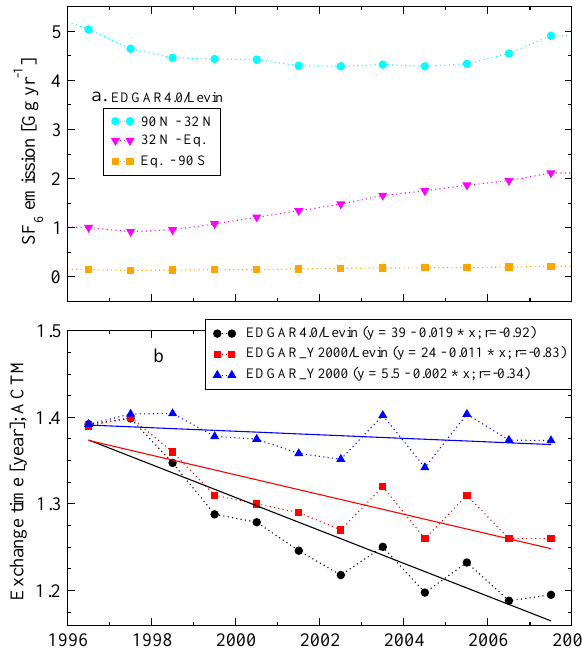
Fig. 9. SF 6 emissions in three broad latitude bands ( a , top panel), and τ ex ( b , bottom panel) estimated using ACTM simulated SF 6 time series for three different emission scenarios. An offset is ap- plied to each τ ex time series for a common value of 1.39yr in